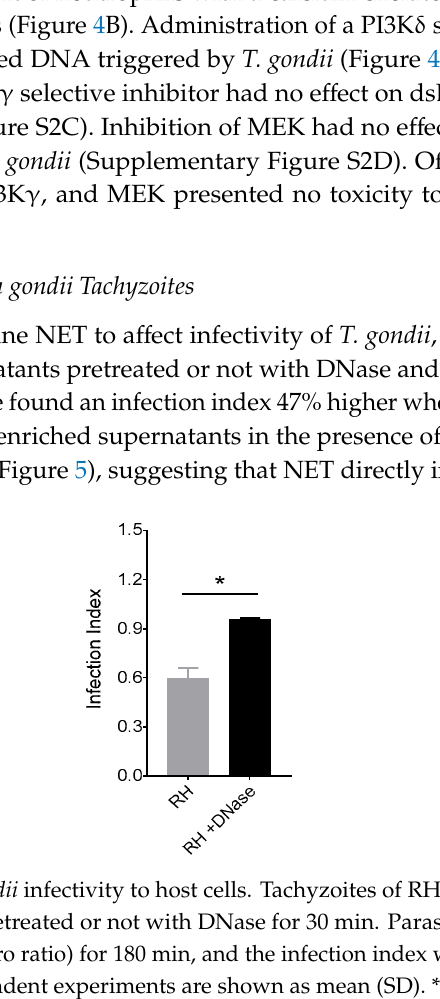
Figure 4. Classical NET ‐ derived DNA release in response to T. gondii involves elastase, intracellular calcium, and PI3K δ . Neutrophils were pretreated or not with ( A ) the elastase inhibitor MeOSuc ‐ AAPV ‐ CMK (Eli; 10 μ g/mL), ( B ) the intracellular calcium chelator BAPTA/AM (BAPTA; 10 μ M), or ( C ) the PI3K δ selective inhibitor IC87114 (IC87; 1 μ M) for 30 min and then stimulated for 180 min with RH tachyzoites (5:1 parasites:neutrophil ratio). Supernatants were collected and released dsDNA was quantified with PicoGreen Kit ( n = 9–13). All results are shown as mean (SD). * p < 0.05; ** p < 0.01; *** p < 0.001.